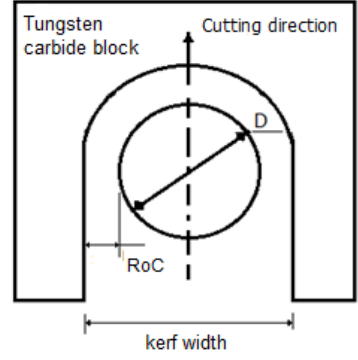
Figure 2. Representation of RoC in